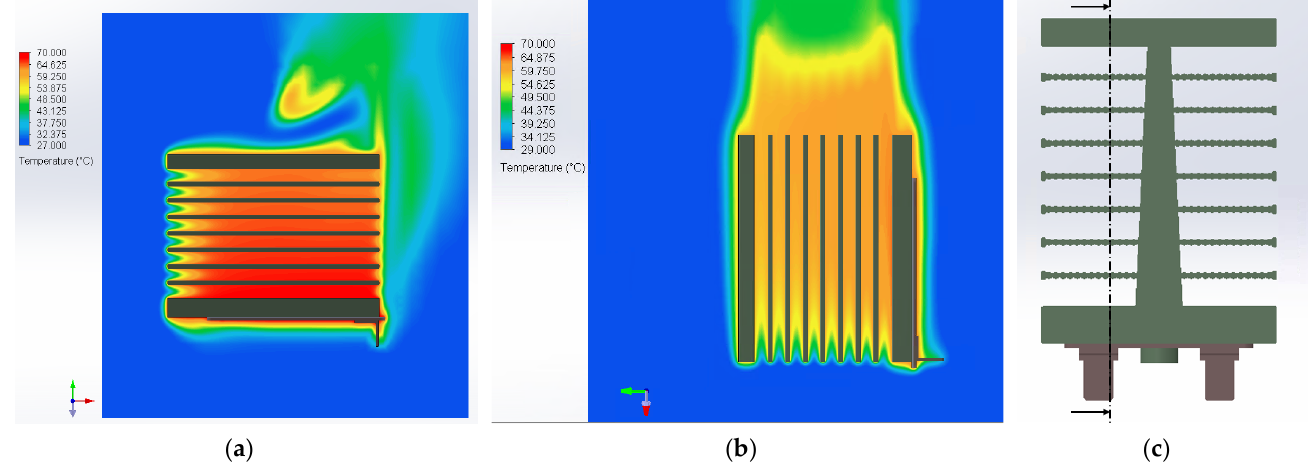
Figure 19. ( a ) Air temperature of Setup 3—section view; ( b ) Air temperature of Setup 4—section view; ( c ) Section plane.